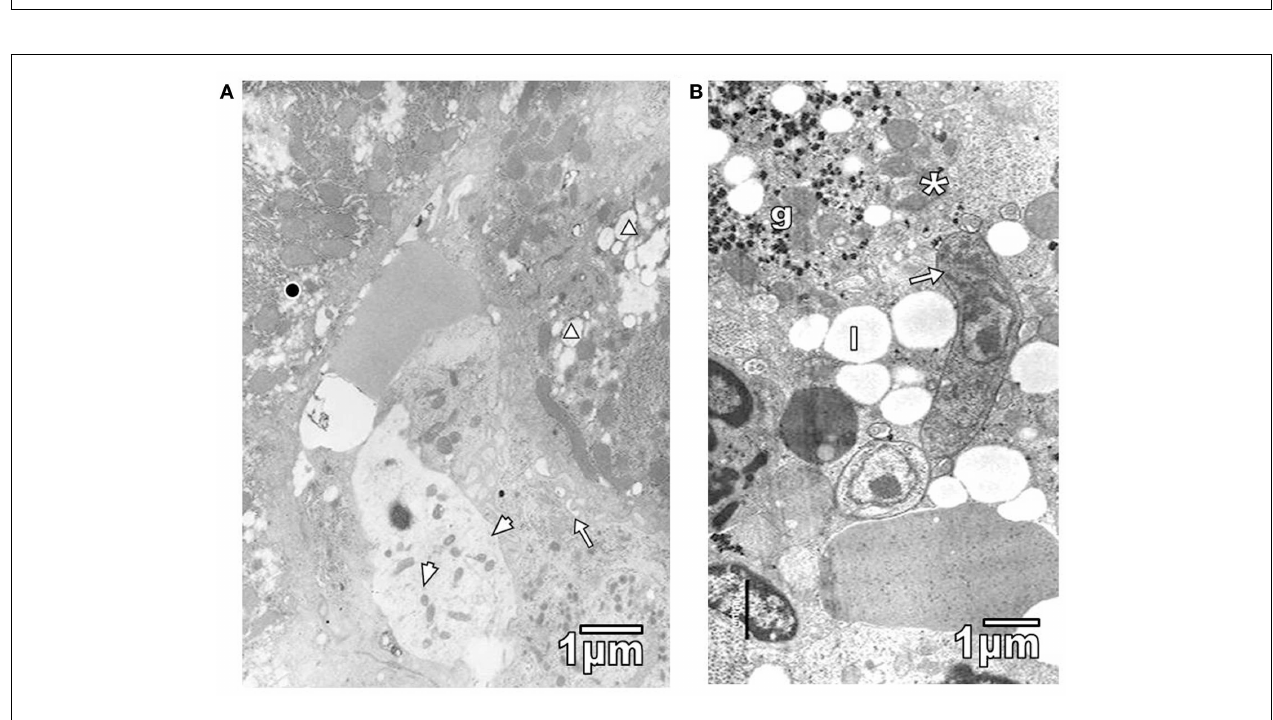
(rhombus) spaces are slightly widened. Observe a parasite (black circle) inside of neutrophil (square). (C) Section of skeletal muscle from a mouse parasitized by T. evansi is shown. Note areas of segmental necrosis (asterisks) showing mitochondrial debris with paracrystalline inclusions (arrows).